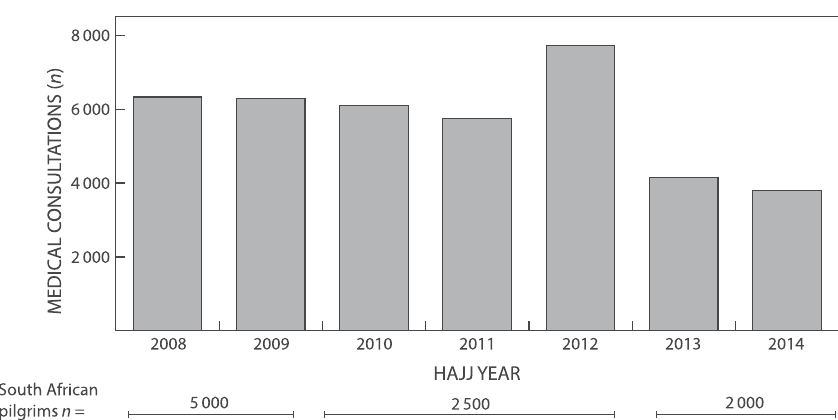
Figure 1: Number of medical consultations among South African Hajj pilgrims 2008 – 2014.